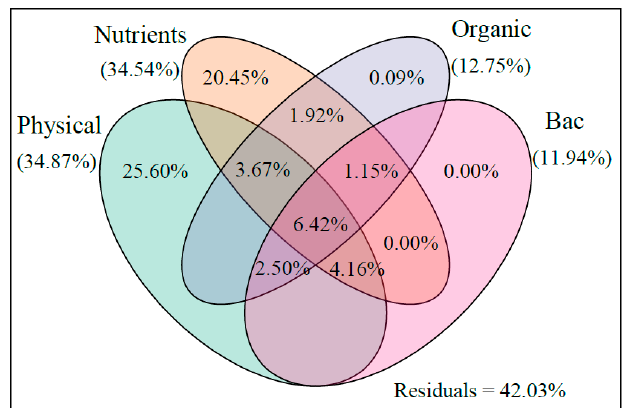
Figure 9. Variation partitioning analysis of the relative contributions of physical parameters, nutrients, organic matter, and bacteria density variables to phytoplankton community structure variation. Physical parameters included T, S, pH, TUR, and DO; nutrients included TAN, NO 3 − , NO 2 − , PO 43 − , and SiO 32 − ; and TN and TP were classified as organic matter. Each number represents the biological variation partitioned into the relative effects of each factor or a combination of factors. The values < 0 are not shown.